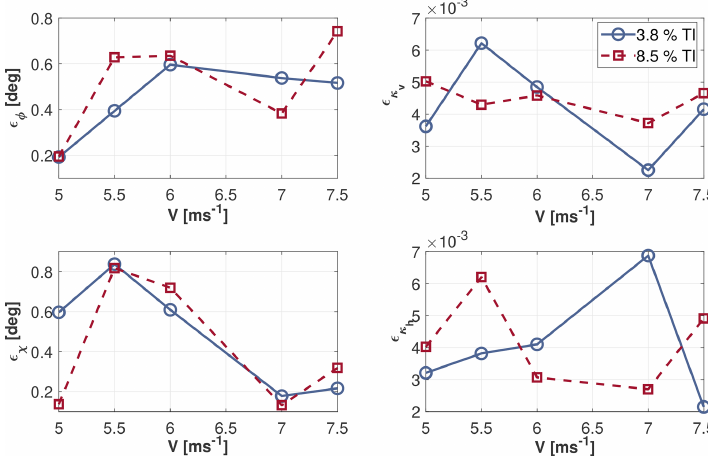
Figure 5. Mean absolute error (cid:15) of the four wind states vs. wind speed for 3.8% and 8.5% turbulence intensity (TI) levels.